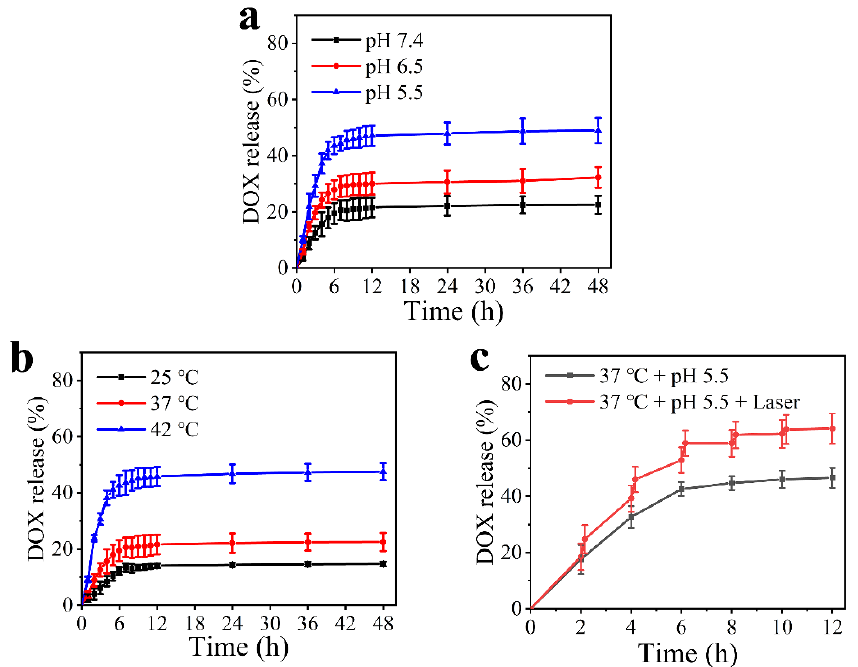
Figure 8. Release profiles of DOX from HAg 2 S@HMPDA/LA-DOX in corresponding release envi- ronment: different pH values ( a ), various temperatures ( b ), and with or without laser radiation ( c ). The drug release of HAg 2 S@HMPDA/LA-DOX nanoparticles can also be triggered by